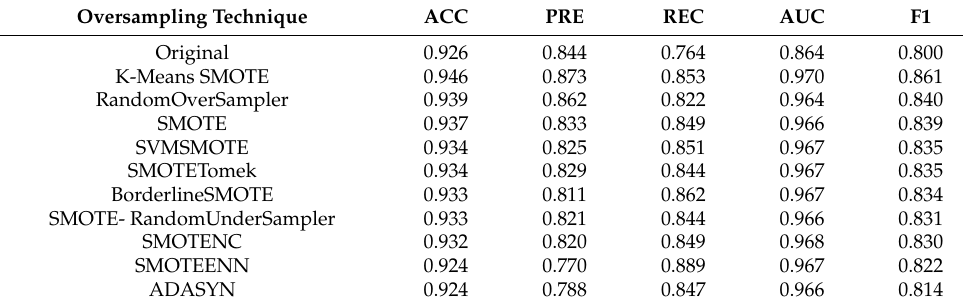
Table 4. Performance evaluation of 10 oversampling techniques.